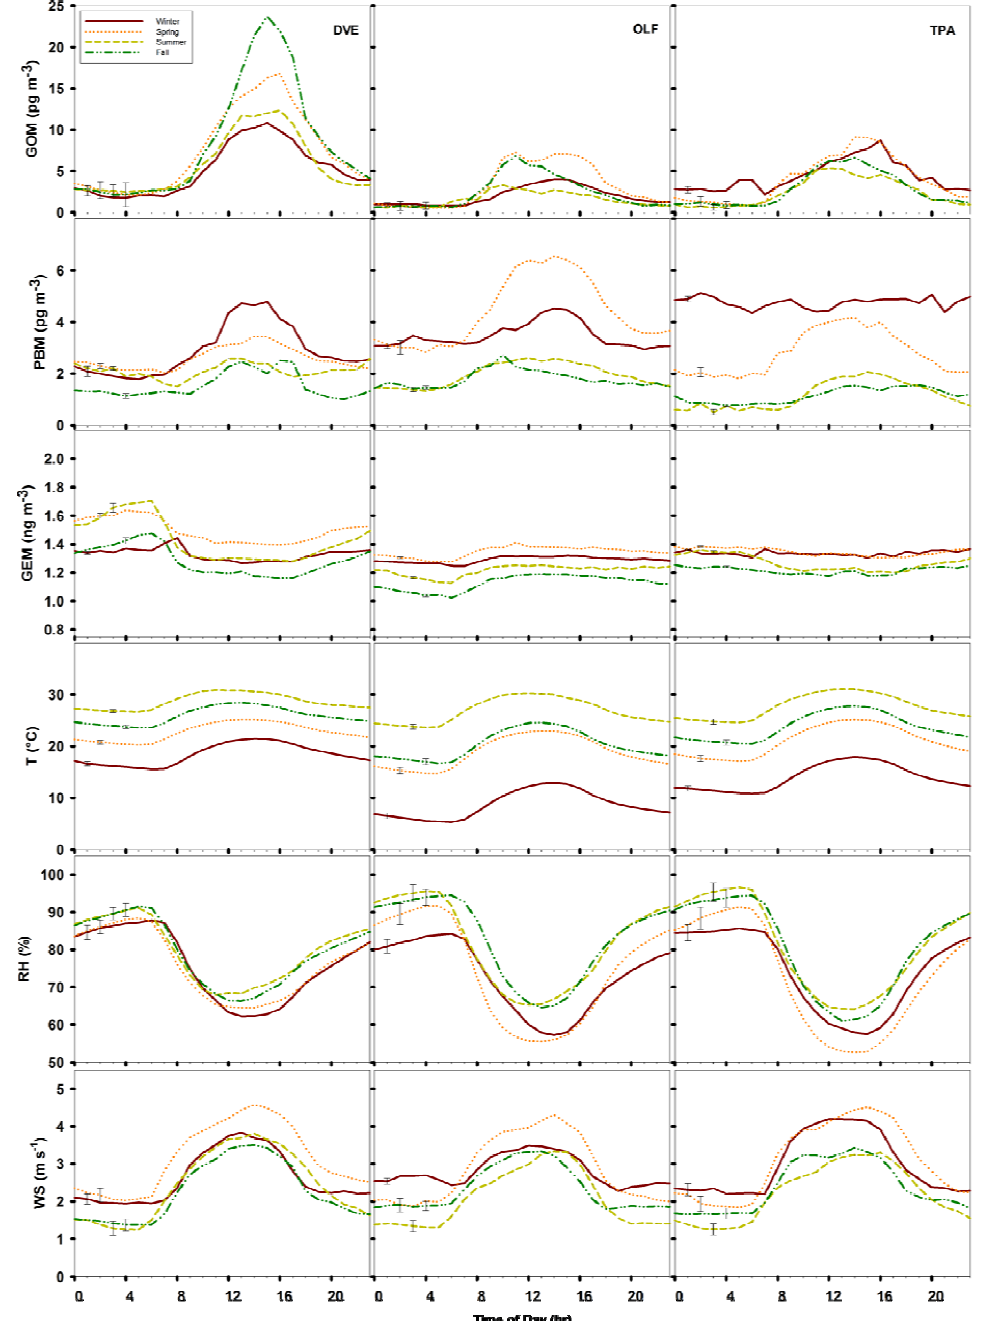
Fig. 3b. Diel bin plots of GOM, PBM, GEM, temperature, relative humidity (RH) and windspeed (WS) also derived using 2-h seasonal